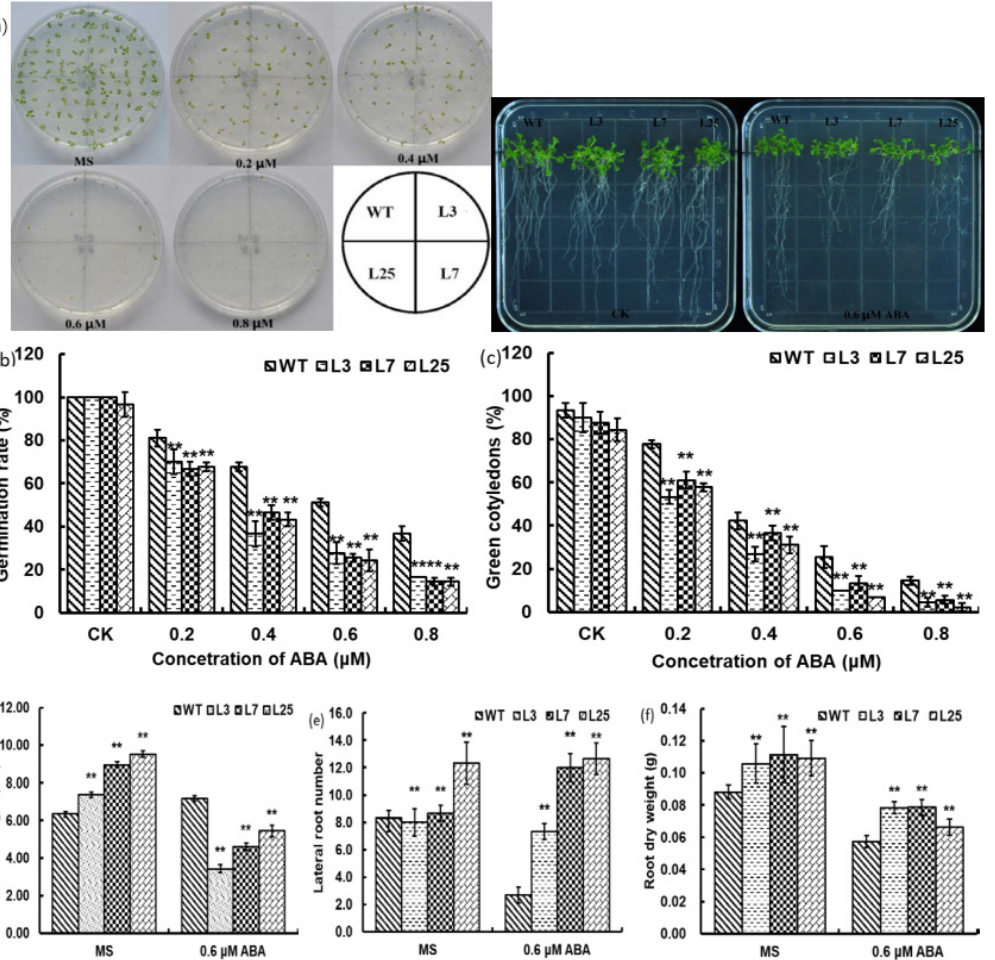
Figure 4. Morphological characteristics of transgenic (L3, L7 and L25) and WT lines at different ABA levels (CK: 0.2, 0.4, 0.6 and 0.8 μ m ABA). ** indicate a significant difference at the 1% level. ( a ) The germination and root morphology of plants treated with ABA were studied. ( b ) Germination rate (%). ( c ) Green cotyledons (%). ( d ) The root length was measured on the 20th day. ( e ) The number of lateral roots was measured on the 20th day. ( f ) Root dry weight was measured on the 20th day ( g ).